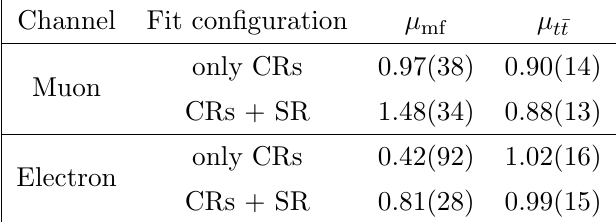
in di(cid:11)erent (cid:12)t regions after t (cid:22) t